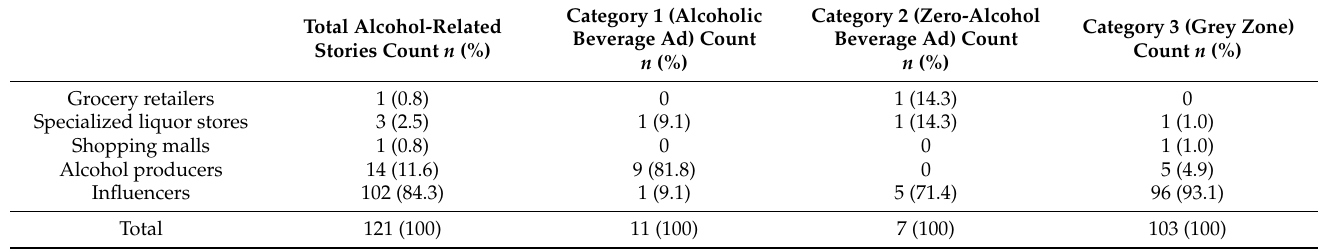
Table 6. Summary of alcohol-related stories by Instagram profile category ( n =